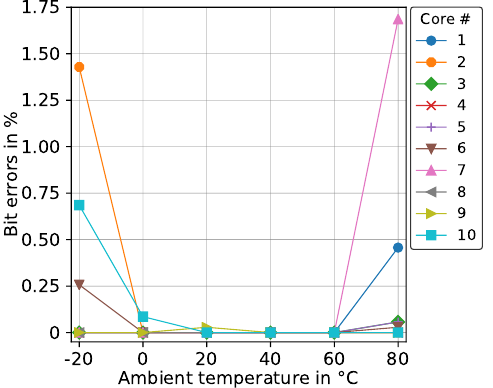
Figure 9. Bit errors over ambient temperature.